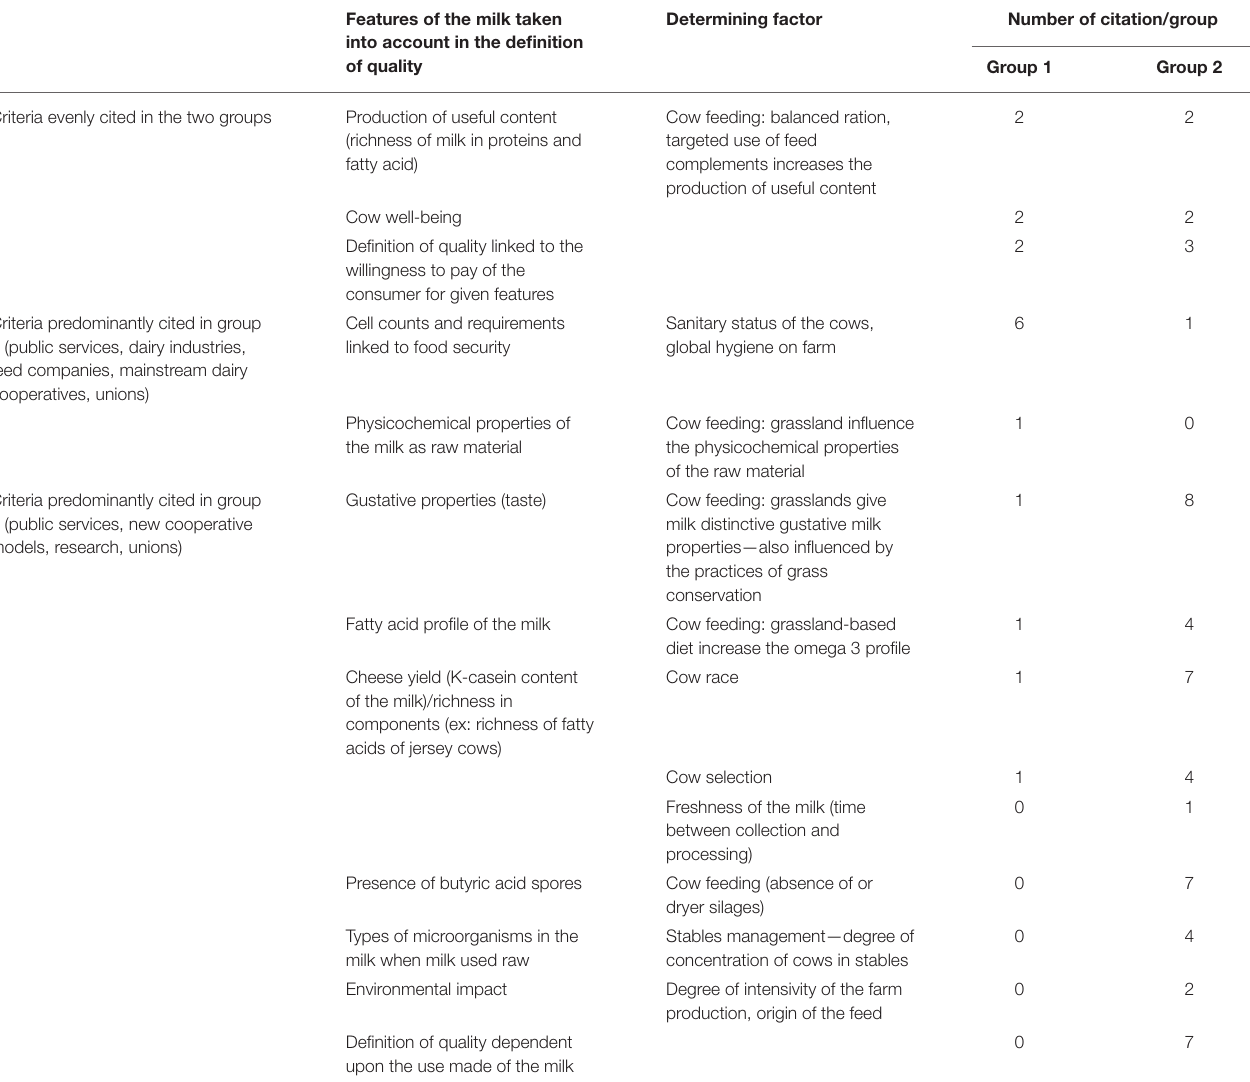
TABLE 3 | Features contributing to the definition of the quality of milk—answers by the interviewees to the question “what defines a milk of quality (milk considered as raw